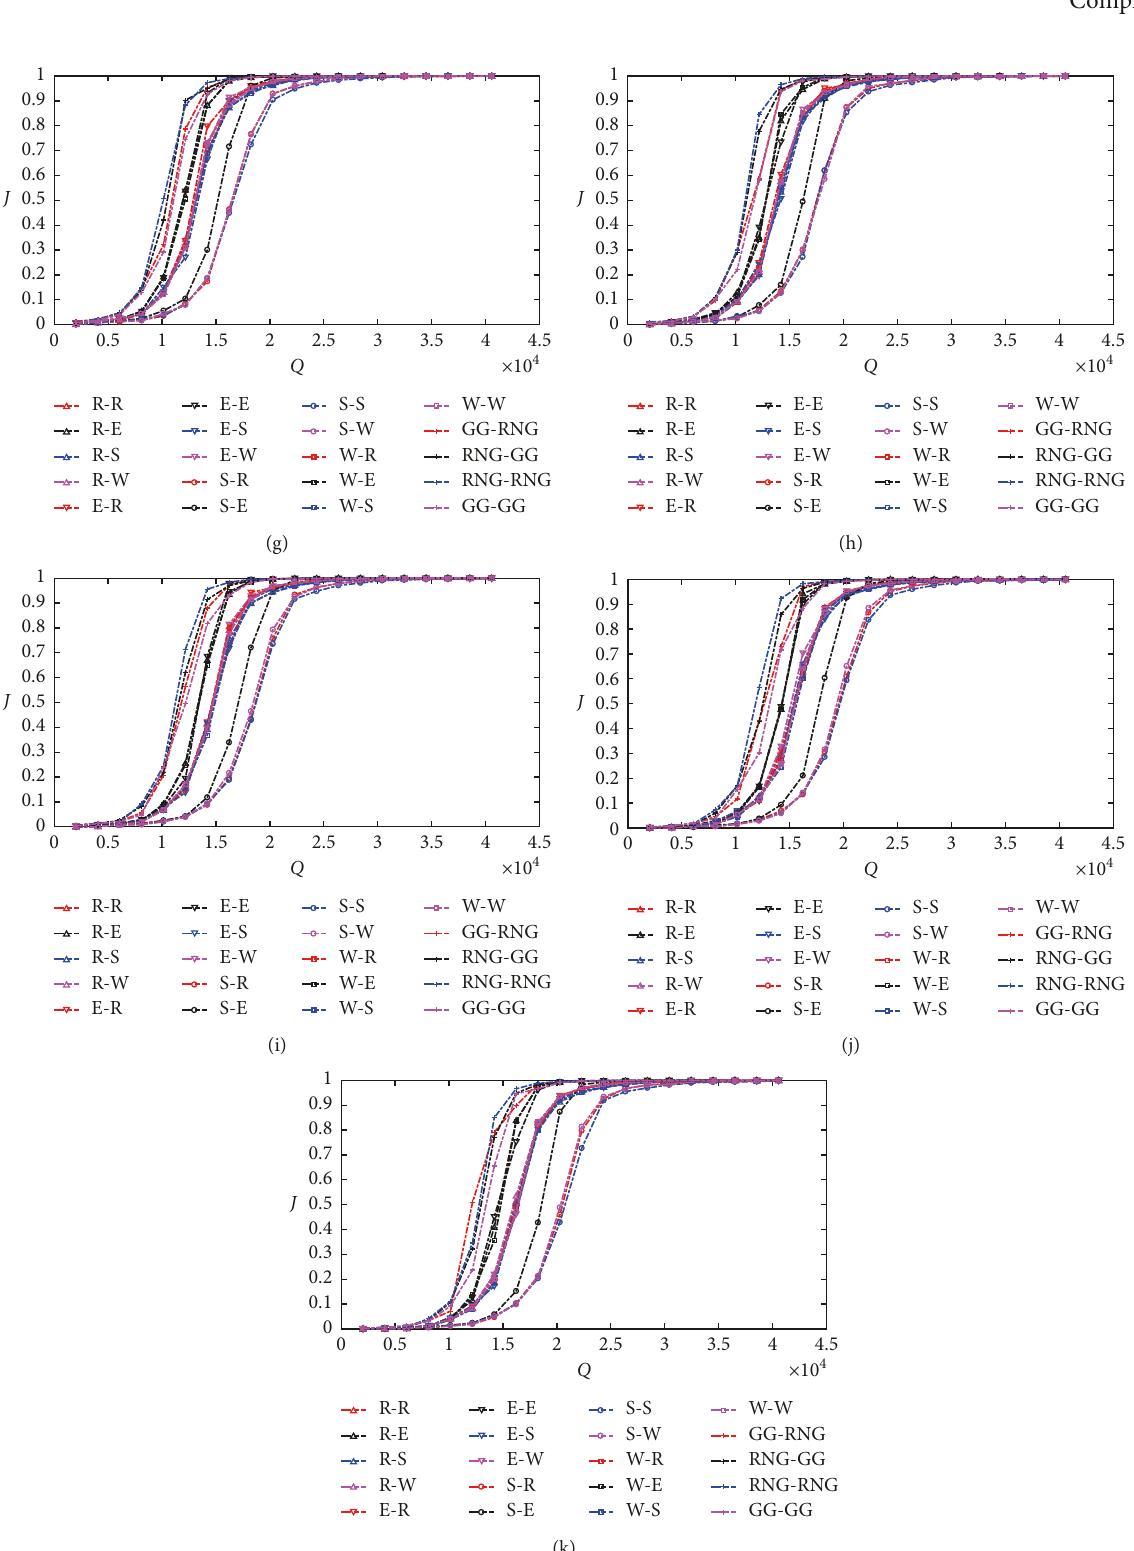
Figure 14: The influence of tunable parameter τ on multilayer networks (with different numbers of nodes) when the networks are completely connected. (a) τ � 1. (b) τ � 1 . 1. (c) τ � 1 . 2. (d) τ � 1 . 3. (e) τ � 1 . 4. (f) τ � 1 . 5. (g) τ � 1 . 6. (h) τ � 1 . 7. (i) τ � 1 . 8. (j) τ � 1 . 9. (k) τ �